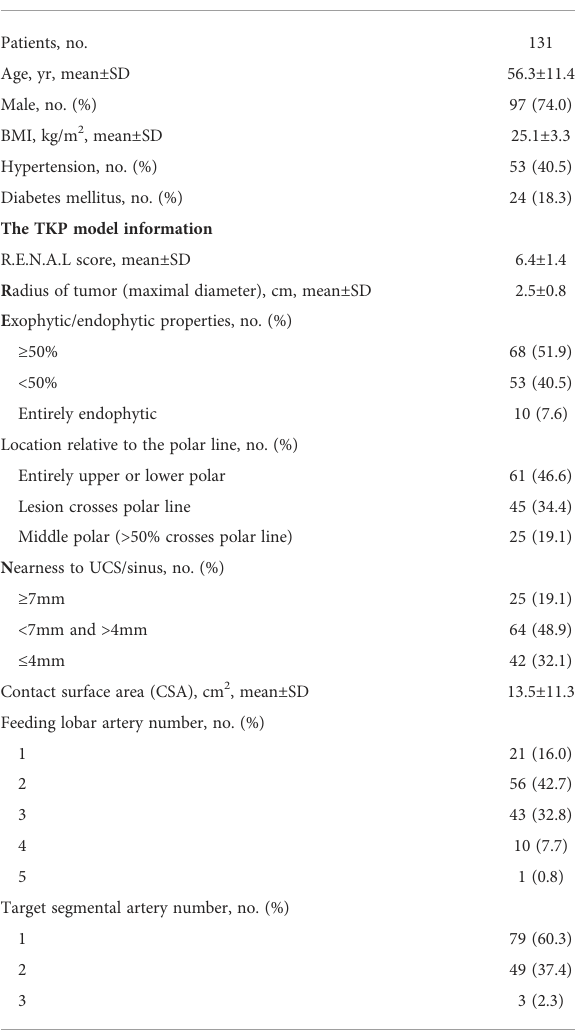
TABLE 1 Patient characteristics and the TKP model